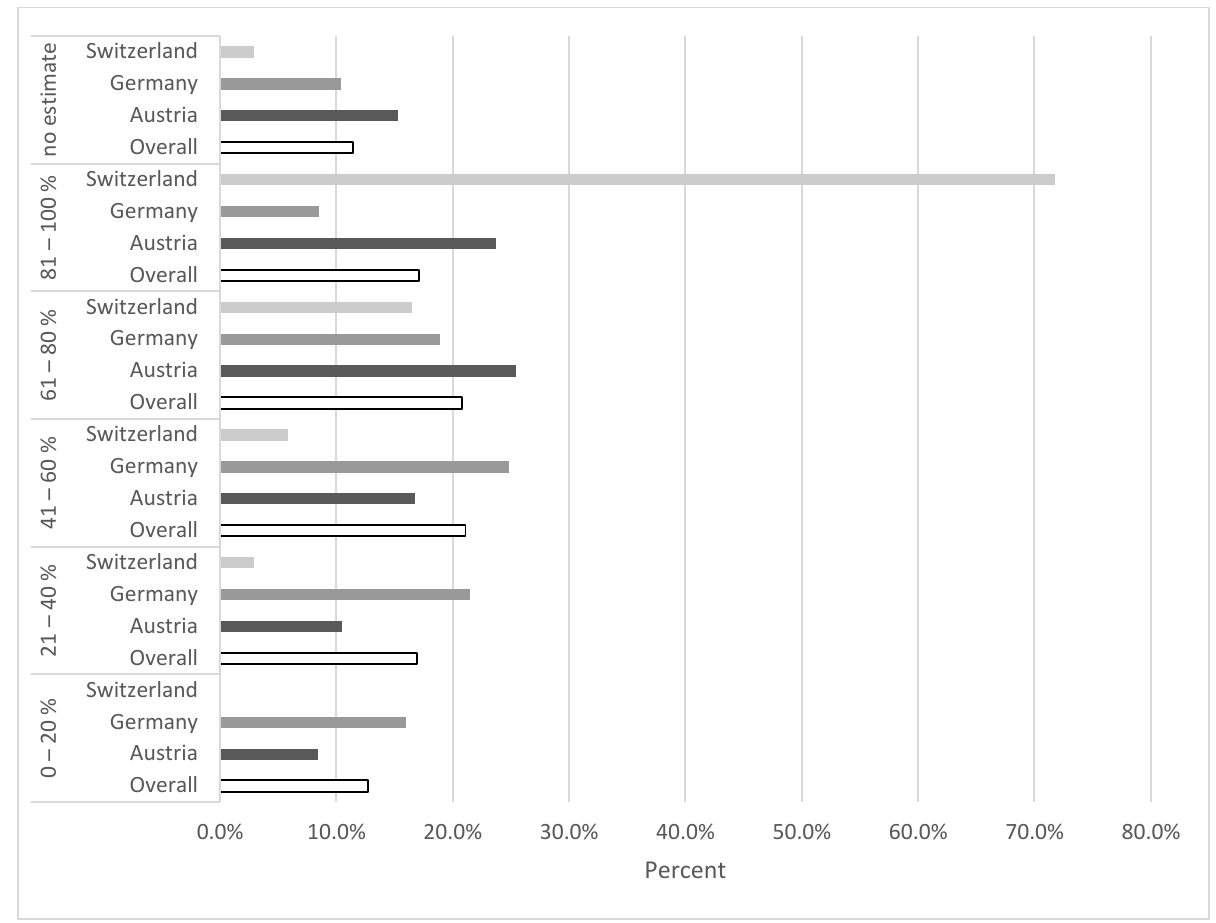
Figure 3. Estimated financial loss in the most unprofitable month during the first peak of the pandemic by partaking countries .